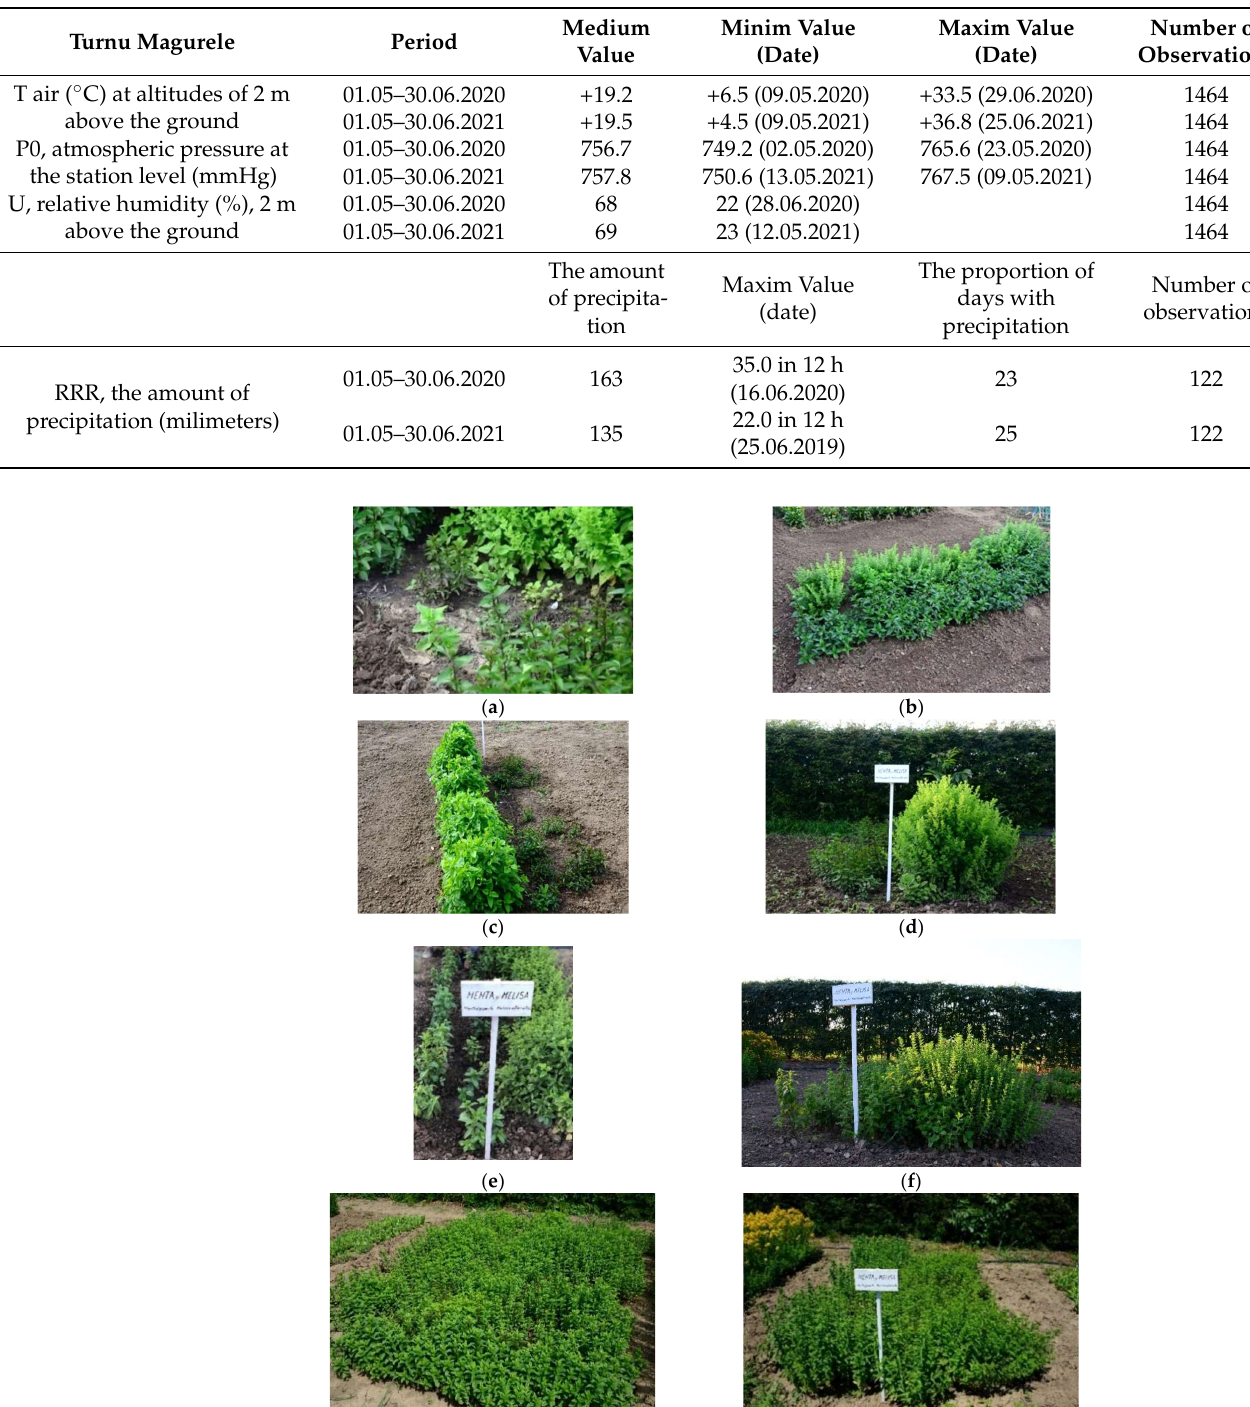
Table 2. Climatic conditions in Turnu Magurele town (Romania) during 2020–2021 according to ANM (National Weather Service) [27].